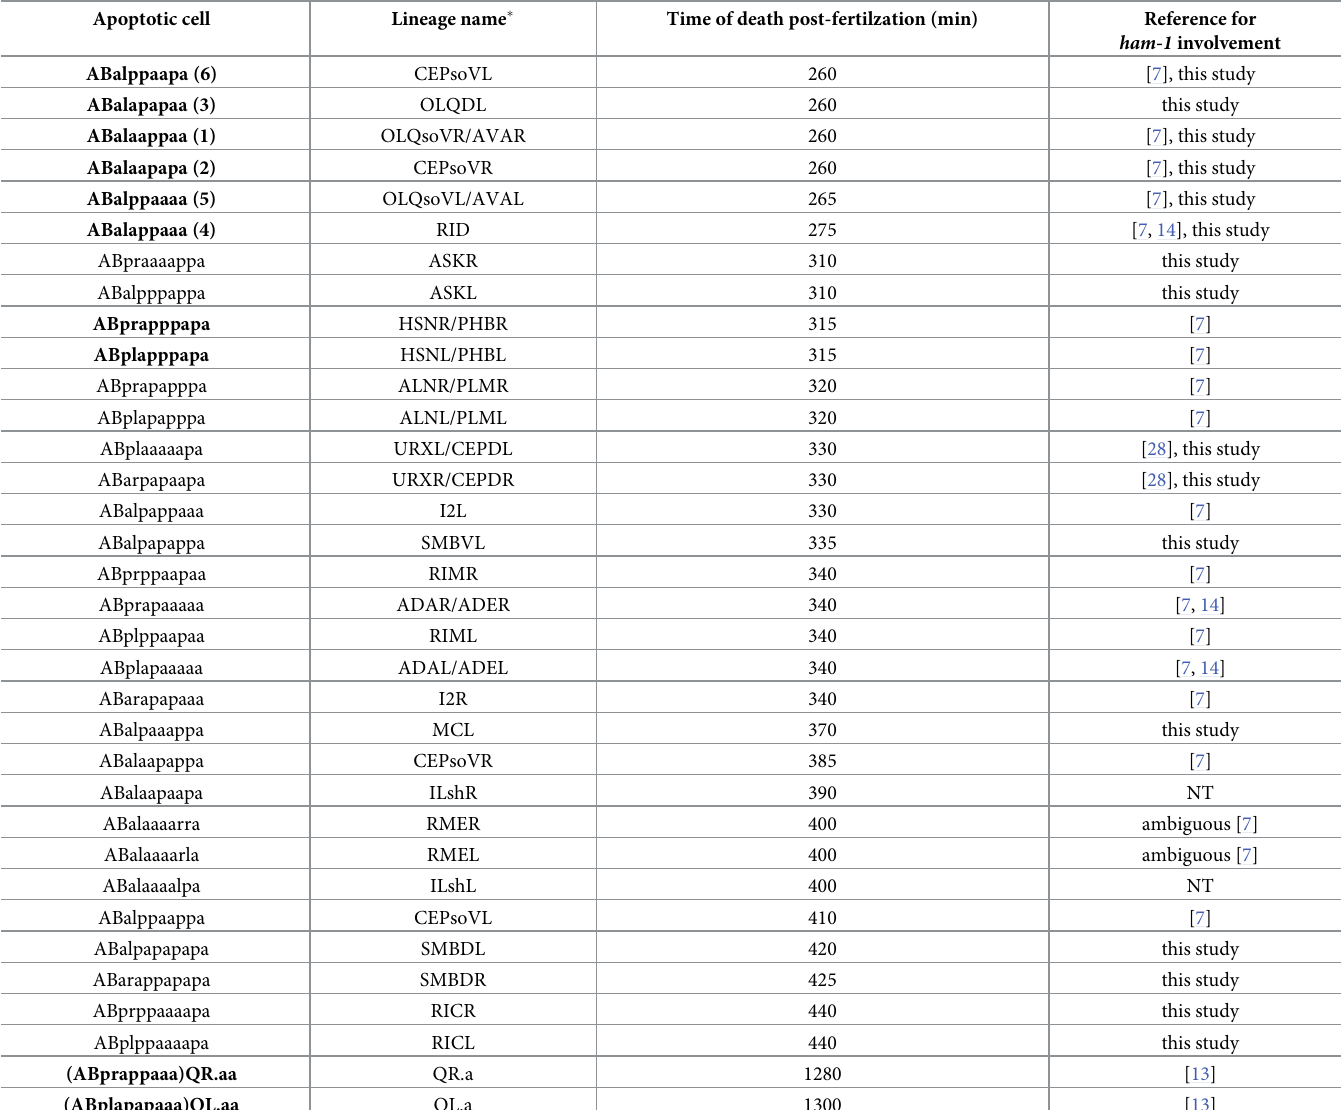
Table 1. ham-1 mutant extra cell phenotypes. Apoptotic cell Lineage name (cid:3) Time of death post-fertilzation